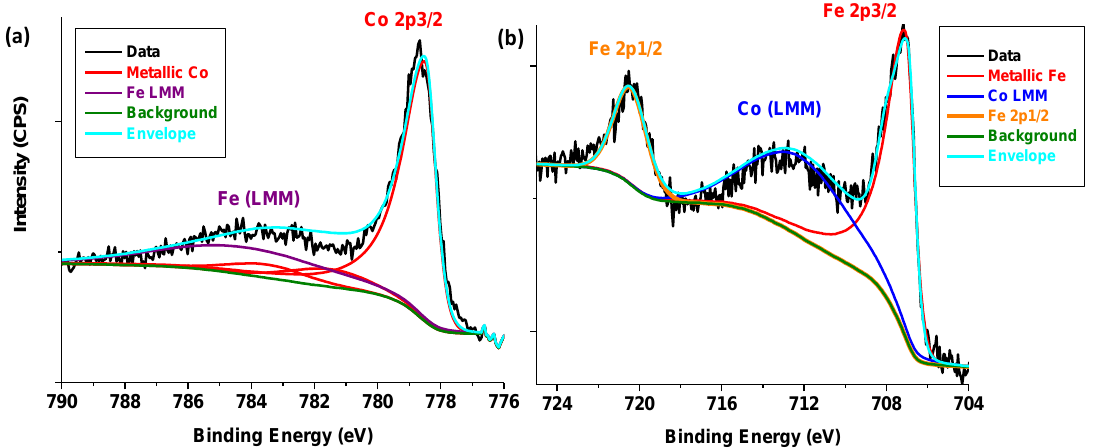
Figure 16. The XPS analysis of ( a ) Co metal, and ( b ) Fe metal in the fresh Co-Fe/C catalyst samples collected from the main plasma reactor.